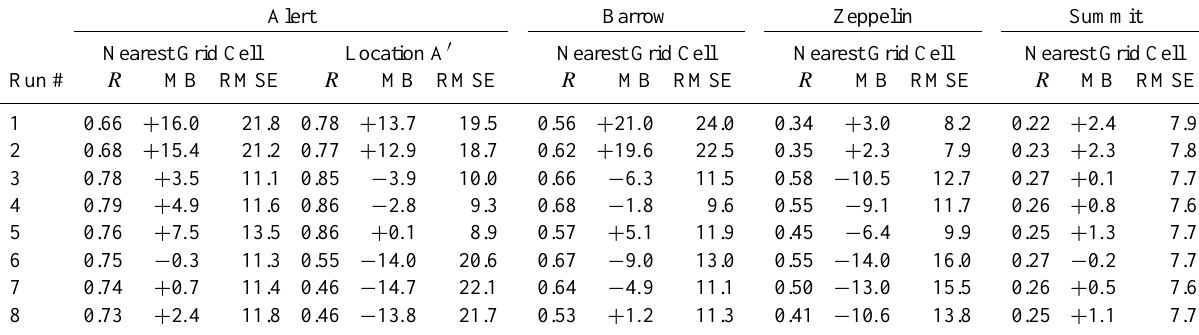
Table 4. Correlation coefficients ( R ), mean biases (MB, in nmolmol − 1 ) and root mean squared errors (RMSE, in nmolmol − 1 ) of simulated surface ozone mixing ratios against hourly observations at Alert, Barrow, Zeppelin and Summit for all the model runs. The simulated values are taken from the lowest model level, except for Zeppelin where the fourth vertical model level ( ∼ 470ma.s.l.) is chosen to match the altitude of the station. The nearest grid cell for Alert has a grid-mean terrain height of 565ma.s.l., which is significantly higher than the actual height of surface ozone measurements (210ma.s.l.); therefore, the statistical metrics are also presented for the third lowest vertical level ( ∼ 170ma.s.l.) at one of the neighboring grid cells (location A 0 in